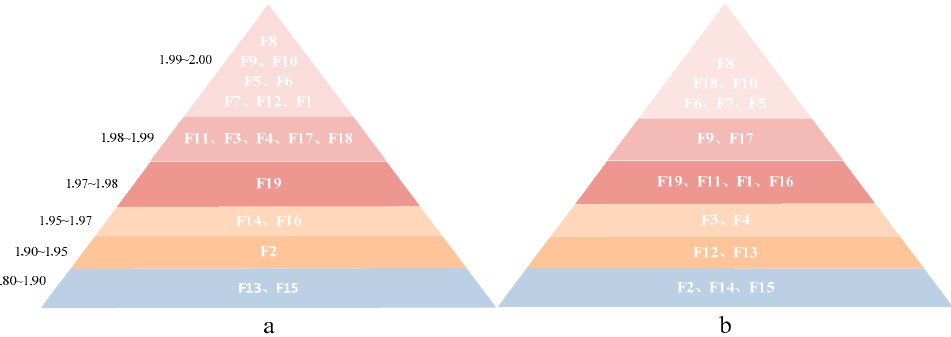
Figure 16. Feature gradient distribution map of data a and data b: red for the first gradient, orange for the second gradient, blue for the third gradient. The depth of the color represents a numerical change in the J–M distance. The lighter the color, the larger the J–M distance of the corresponding feature, and the better the separability of oil spill and seawater.